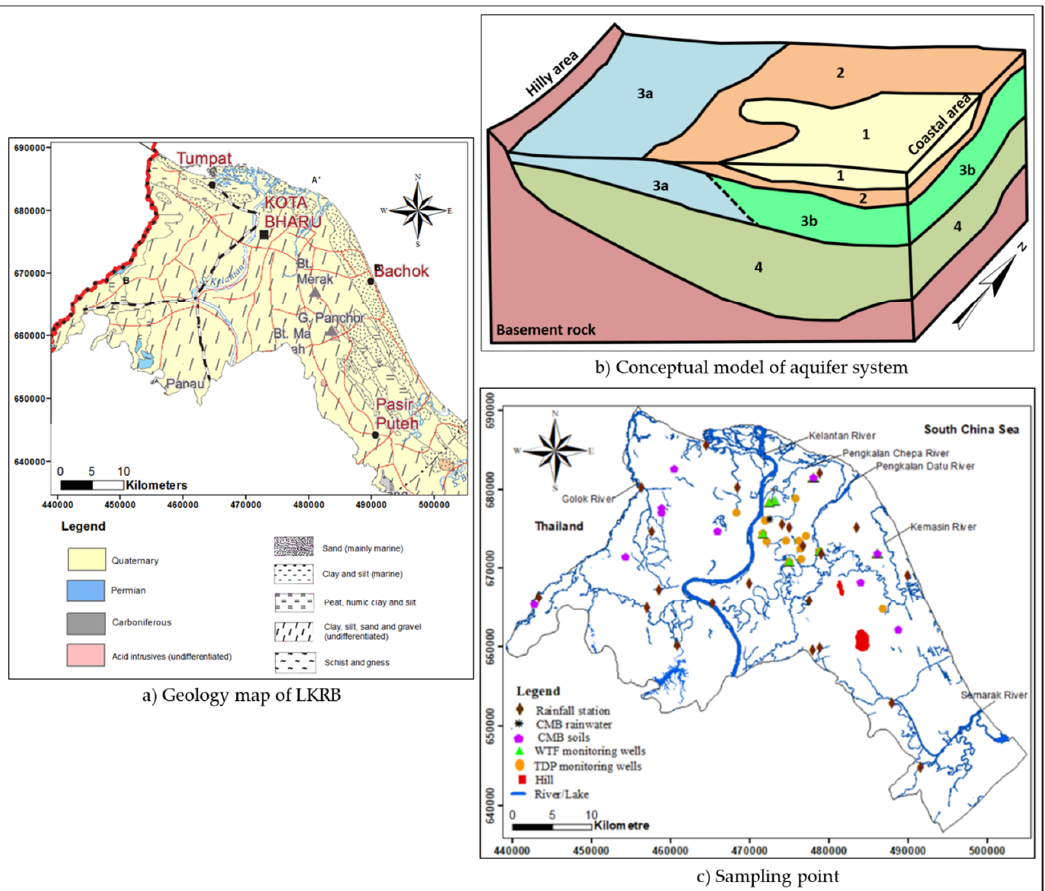
Figure 1. ( a ) Geology map of Lower Kelantan River Basin (LKRB) (modified from [47]); ( b ) Conceptual model of aquifer system [46]; and ( c ) Sampling point.